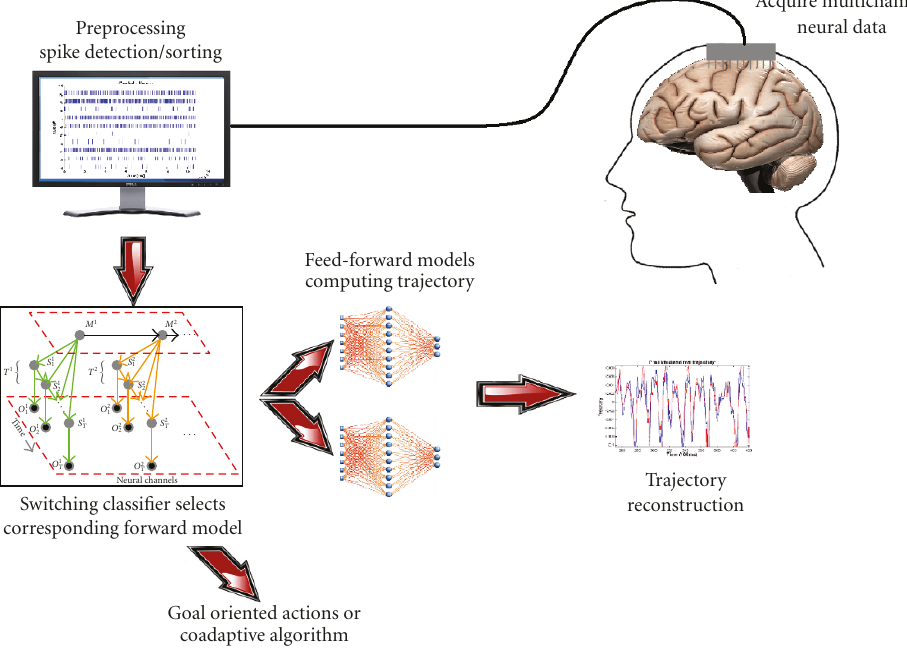
Figure 1: BMI system overview.